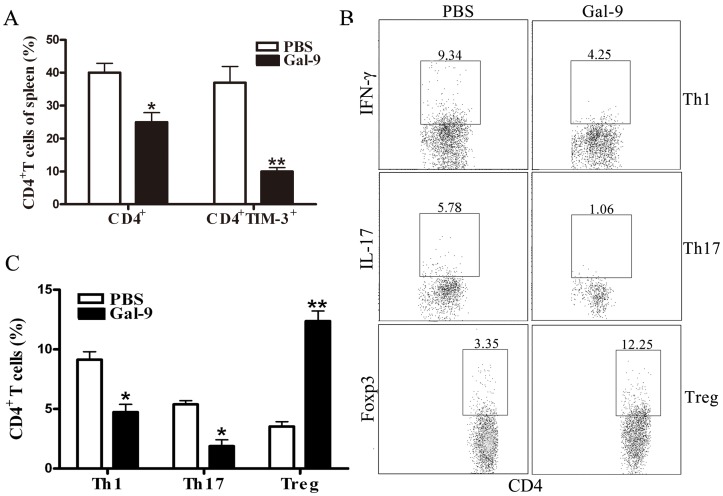
Effect of galectin-9 treatment on cellular infiltration in spleen of Con A treated mice.Galectin-9 (100 µg per mouse) or PBS was administrated i.v. to Balb/c mice (n = 8 per group) 30 min before Con A injection (20 mg kg–1). The splenocytes were isolated 24 h later. Percentages and phenotype (surface TIM-3) of CD4+ T cells in spleen of mice are shown in (A). (B) The frequencies of Th1, Th17 and Treg subsets were detected by FACS. Statistically significant differences were indicated in (C). The results (A, C) were presented as the mean ± SD of three separate experiments. **, p<0.01; *, p<0.05 vs PBS treatment.